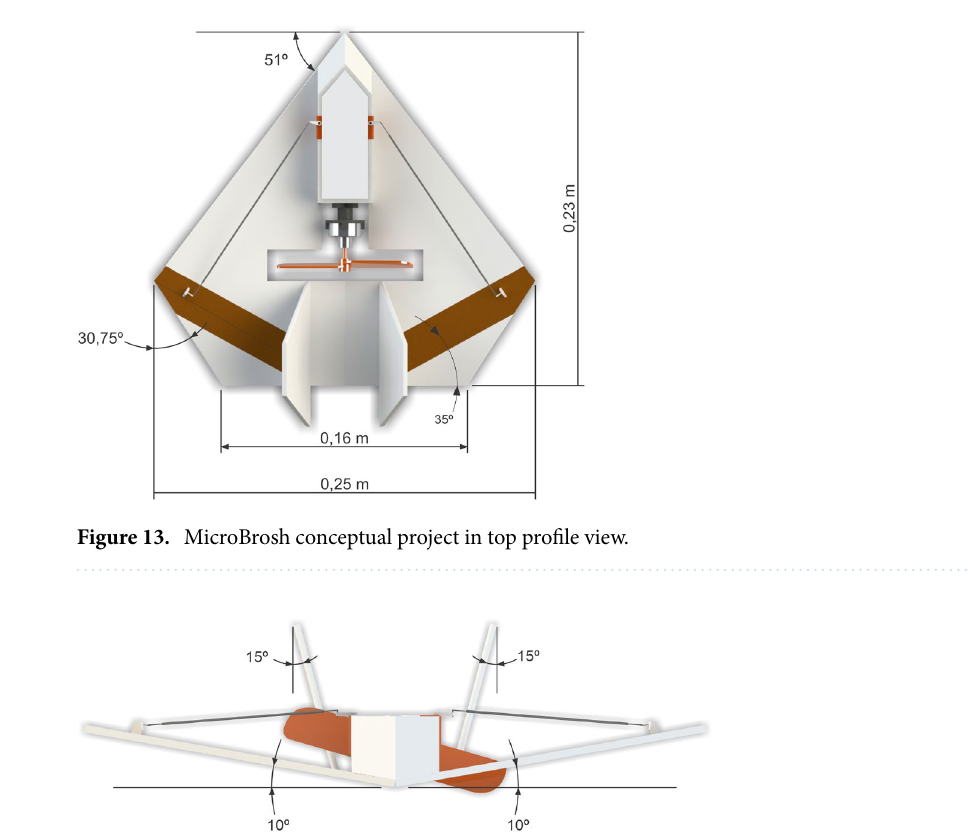
Figure 14. MicroBrosh conceptual project in back profile